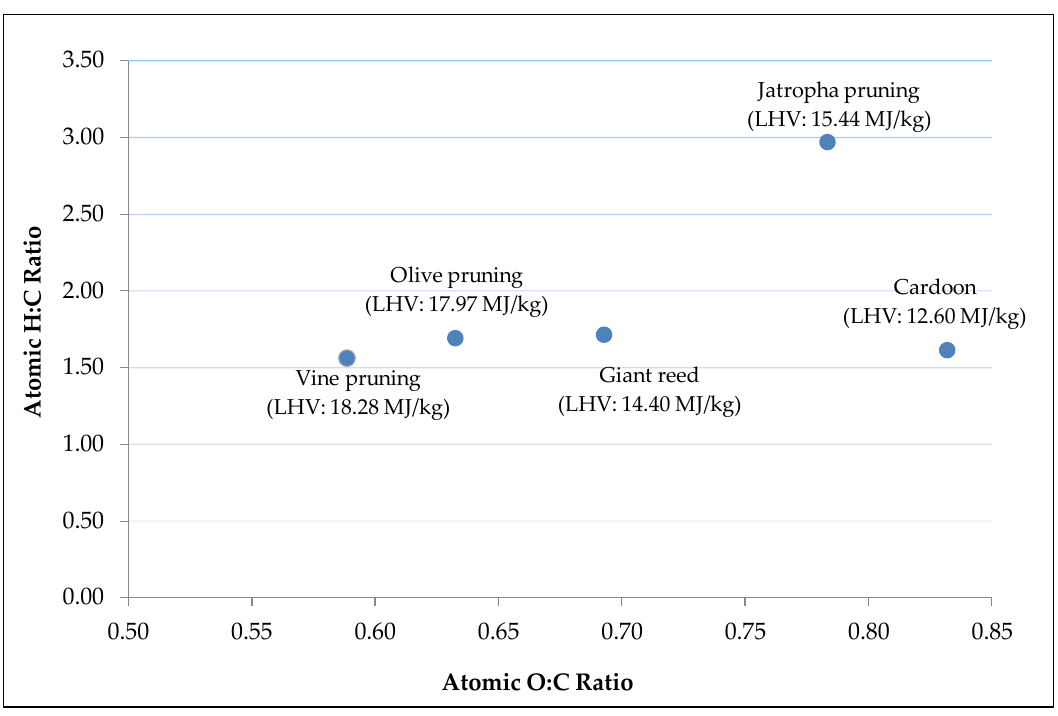
Table 2. Physical characteristics of jatropha wood in comparison with other types of biomass (figures in parentheses are standard deviations).